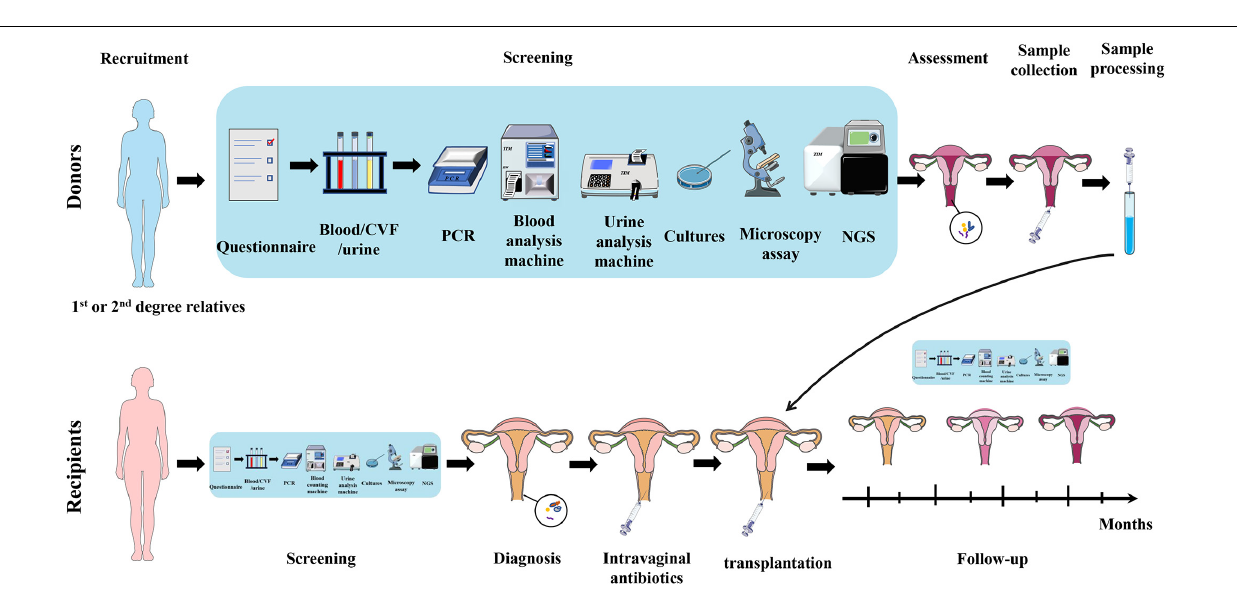
FIGURE 3 | Schematic diagram of VMT operation. As for donors, first, donors are recruited, preferably from the recipients’ first and second relatives. Second, collect blood/CVF/urine samples of donors and conduct a series of screening by questionnaire, PCR, blood, and urine analysis machines, cultures, microscopy, and NGS. Third, collect CVF sample from qualified healthy donor and process it. It is then transplanted into the recipient’s vagina. As for recipients, first, recipients undergo the same screening process for diagnosis and basic health assessment. Second, recipients are given intravaginal antibiotics to prepare for transplantation.